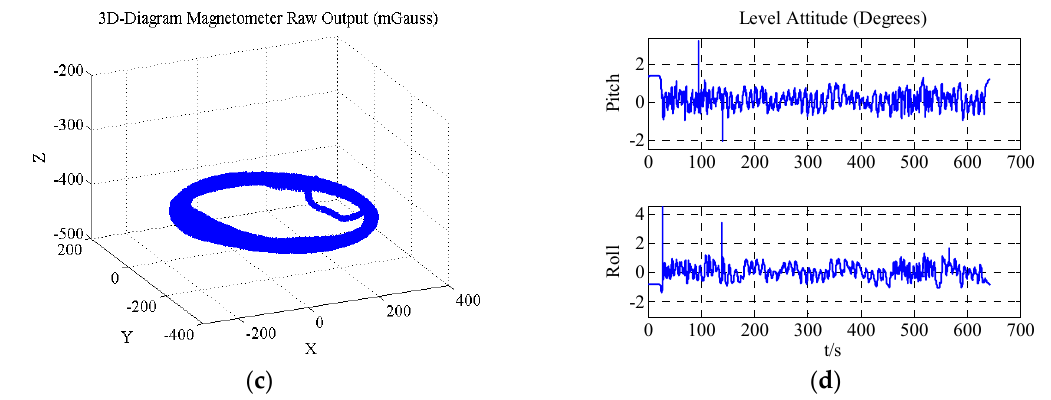
Figure 11. ( a ) Output of the ADIS16488 gyroscope; ( b ) Output of the ADIS16488 magnetometer; ( c ) Three-dimensional diagram of ADIS16488 ′ s magnetometer output; ( d ) Level attitude of the system.